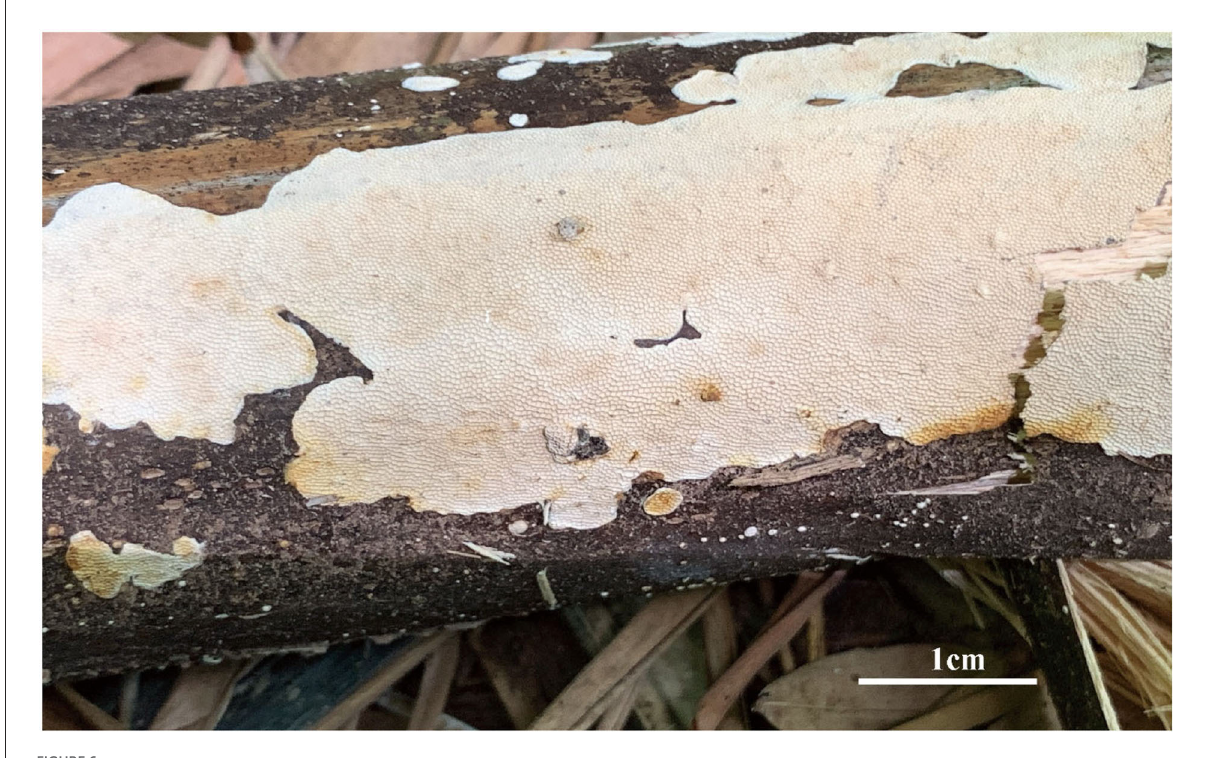
FIGURE6 Basidiocarps of Jorgewrightia tenuis (holotype, Dai